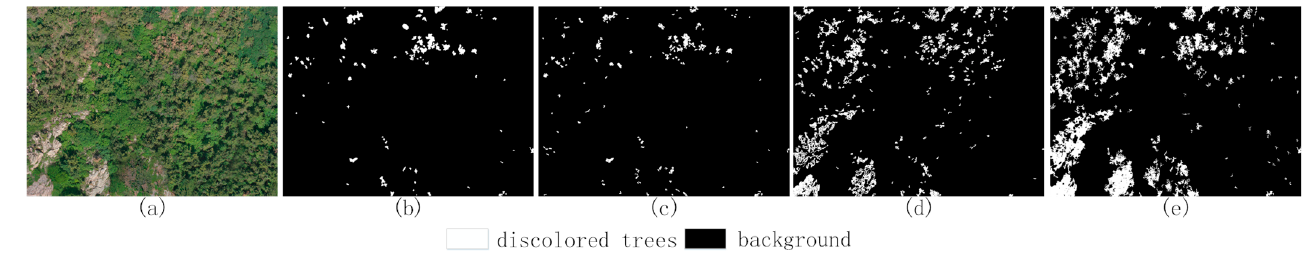
Figure 9. Extraction results by different methods. ( a ) UAV image; ( b ) ground truth; ( c ) our proposed